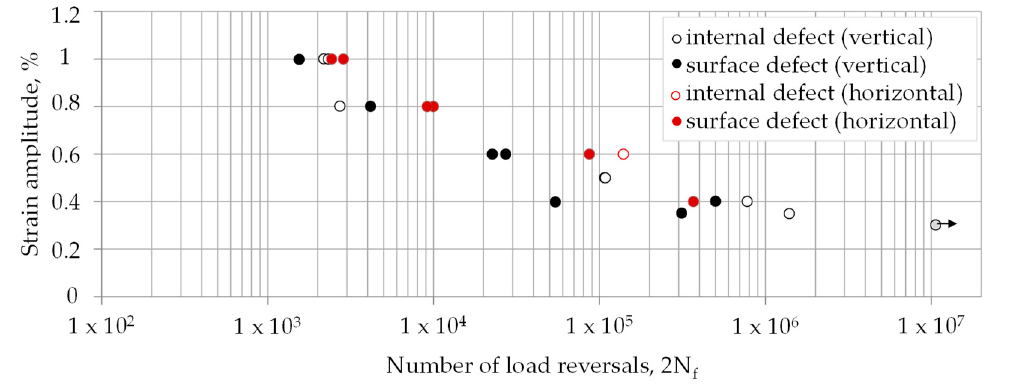
Figure 12. Strain-life data for horizontally and vertically built specimens.